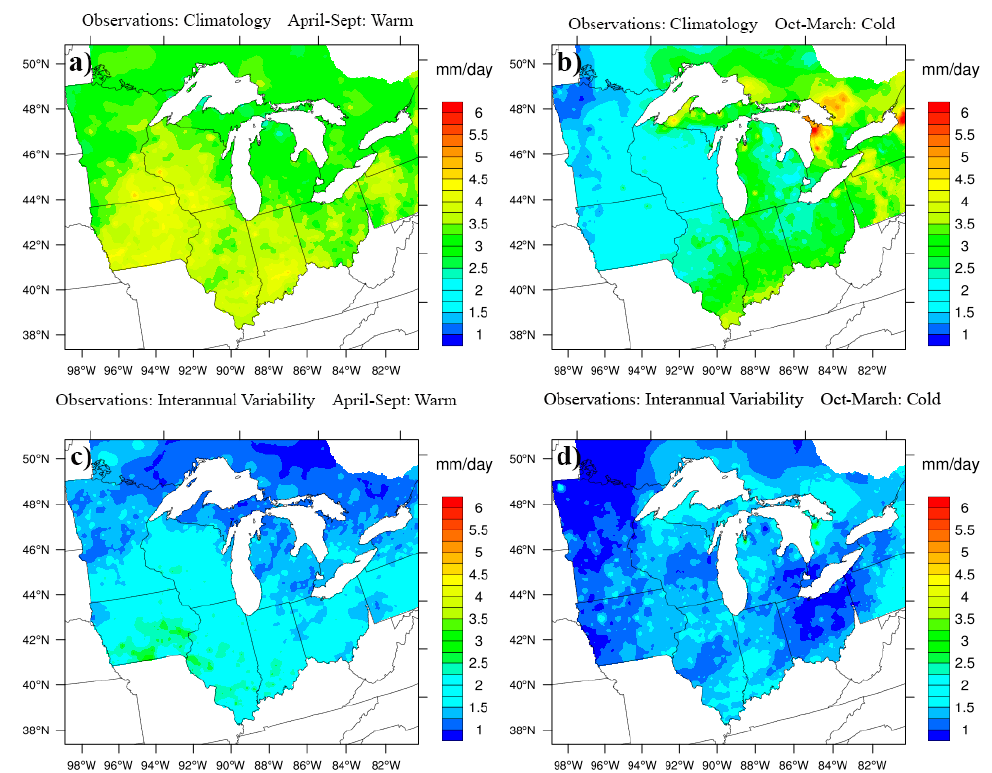
Figure 2. Seasonal climatology of observed gridded precipitation for ( a ) warm season from April–September and ( b ) cold season from October to March for a period of 10 years from the year 1991 to 2000. Similarly, seasonal interannual variability of observed precipitation for ( c ) warm and ( d ) cold season.